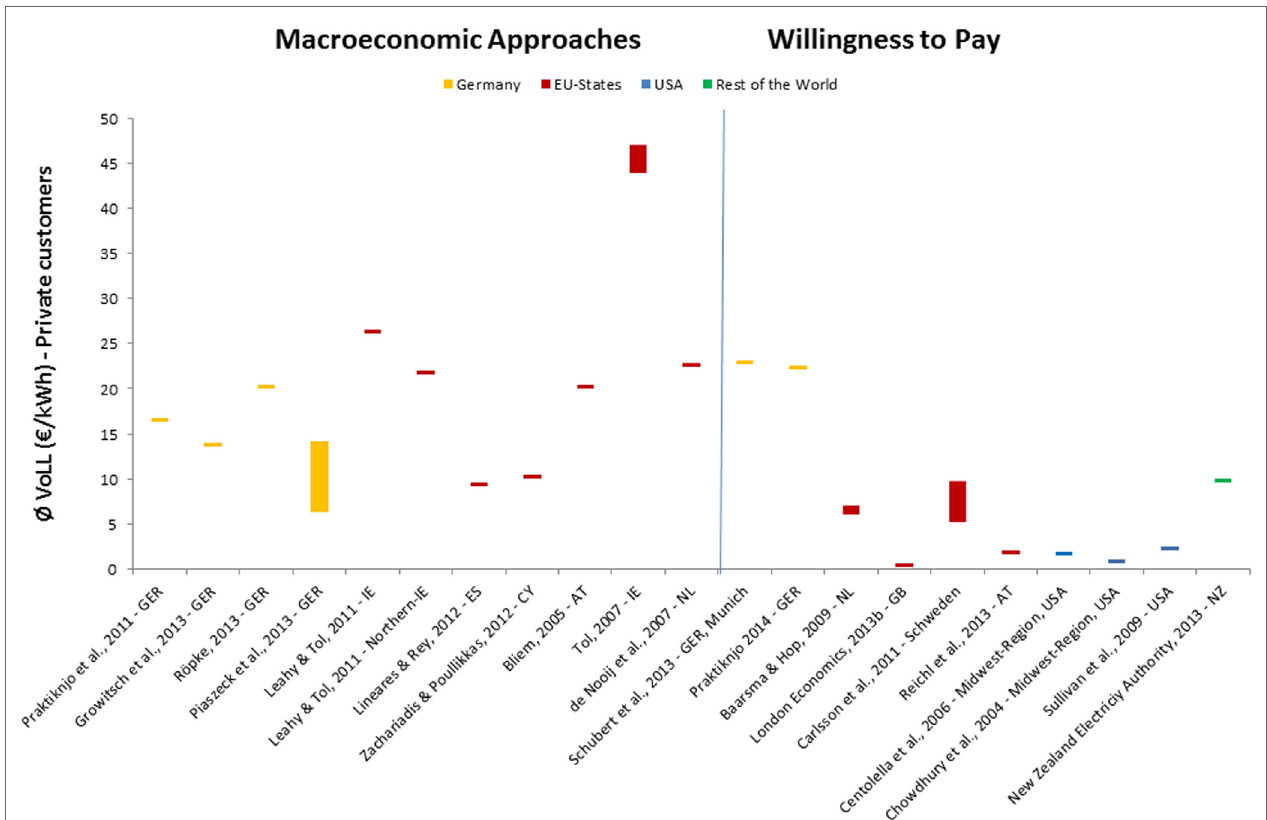
FiGURe 3 | Actual voLL studies – Private end users